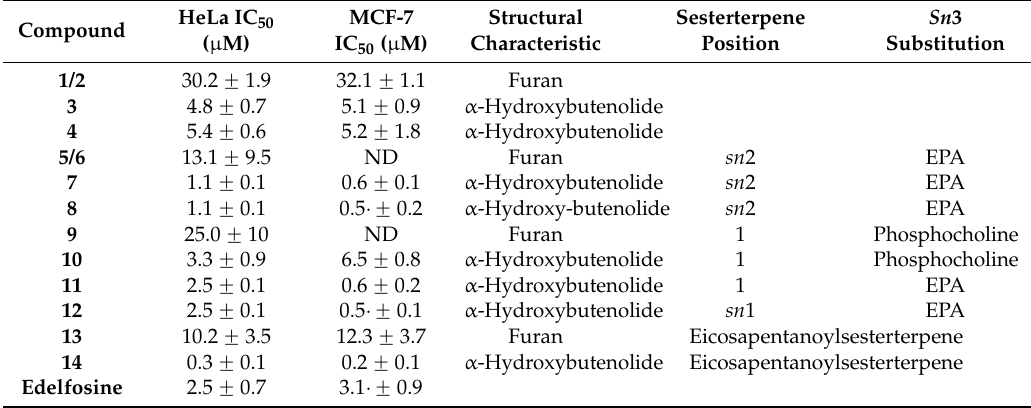
Table 1. IC 50 values of the synthesized compounds against HeLa (human cervix cancer) and MCF7 (human breast cancer) cells. Some natural analogues were included for comparison. Distinct fragments, substitutions or units involved in the structure were included for reference. Sn 3 HeLa IC 50 MCF-7 Structural Sesterterpene Compound ( µ M) IC 50 ( µ M) Characteristic Position